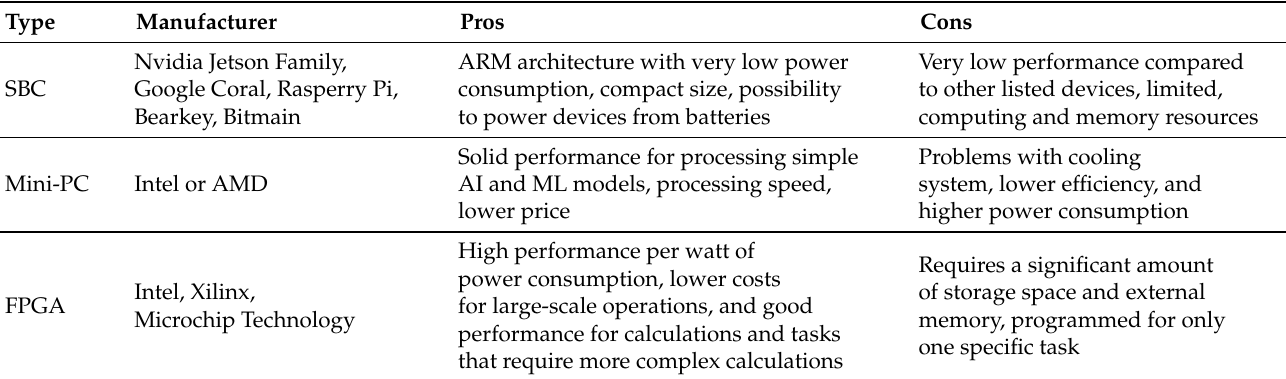
Table 5. Overview of hardware